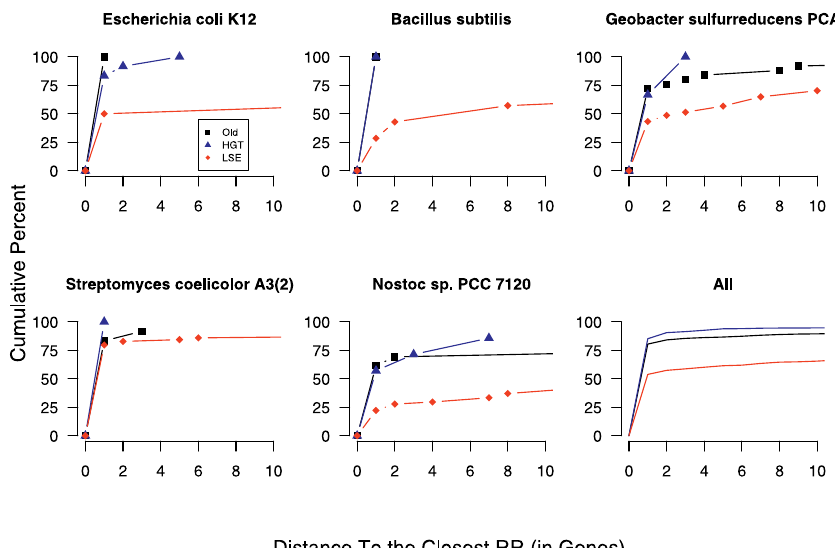
Figure 5. Proximity of Different Classes of HPKs to RRs Shown is the cumulative percentage of HPKs of each type that have RRs within the distance on the chromosome specified by the x -axis. The different gene types shown are: old HPKs — black squares (Old); HGT genes without recent paralogs — blue triangles (HGT); and HPKs with recent paralogs — red diamonds (LSE). In the bottom right panel, an average over all genomes is shown. In general, and for most specific cases (excepting Streptomyces ), horizontally transferred genes are observed to have a much higher fraction of RRs in close genomic proximity. ‘‘ Hybrid ’’ HPKs, which have RRs in the same ORF as the HPK, were excluded from this analysis. Only genes that are not believed to have undergone duplication within a lineage are used in the HGT group. Lines stop when cumulative percentage equals